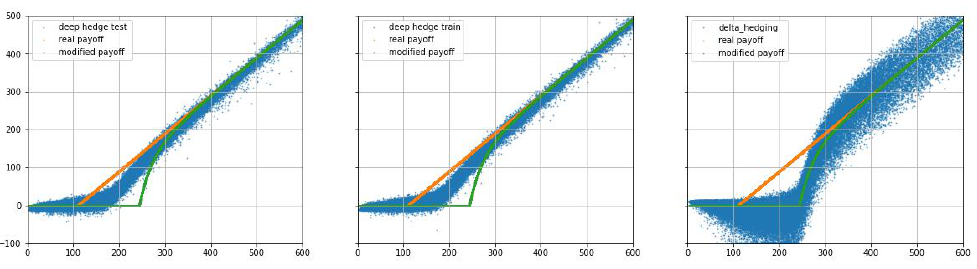
Figure 3. Terminal wealth ( p = 1.1).